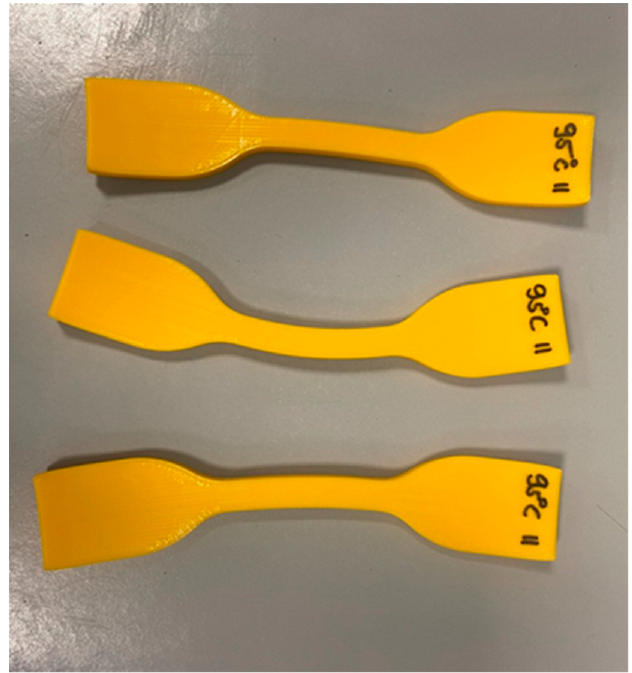
Figure 3. Deformed specimens after heat treatment.